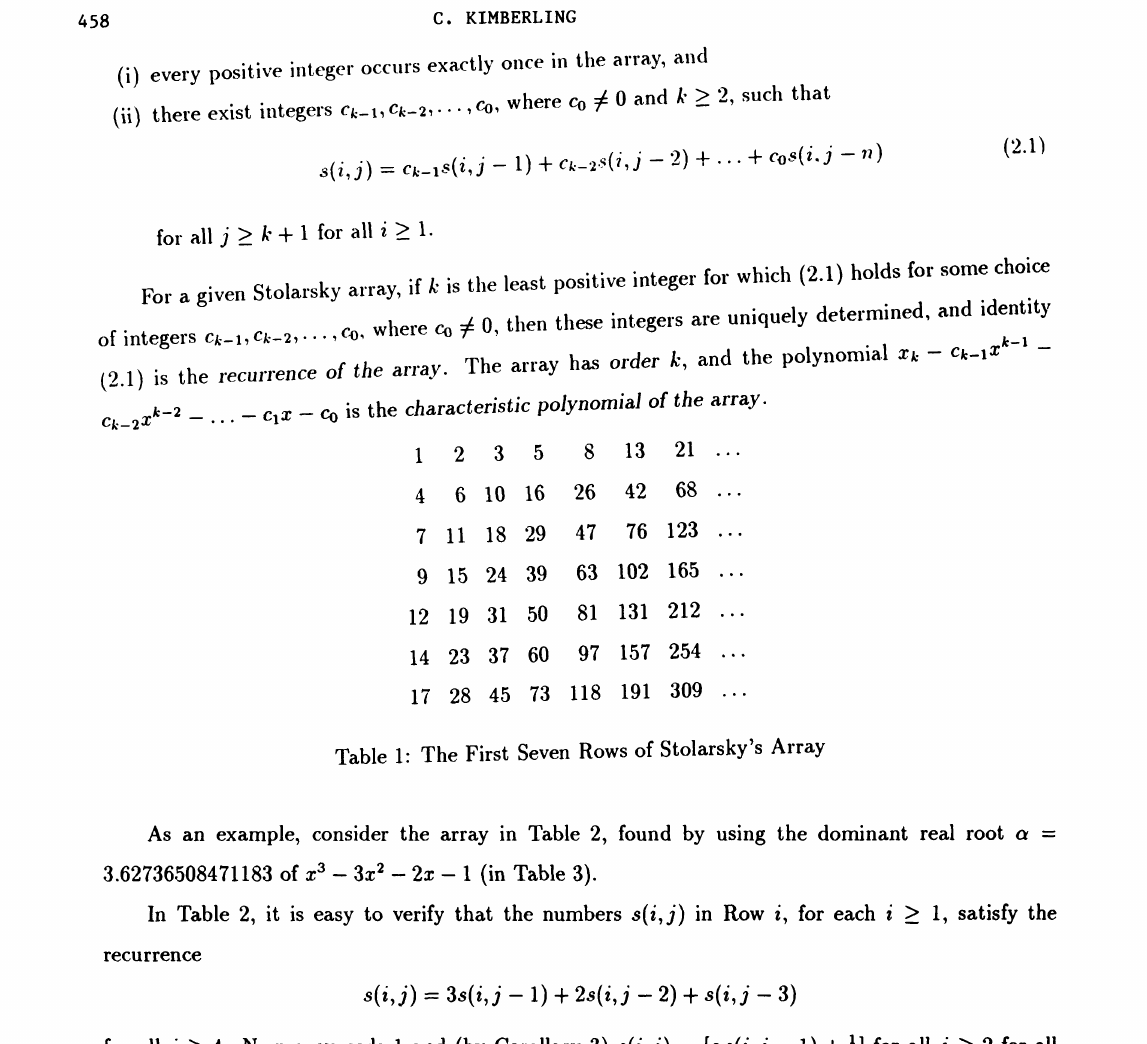
Table 1: The First Seven Rows of Stolarsky’s